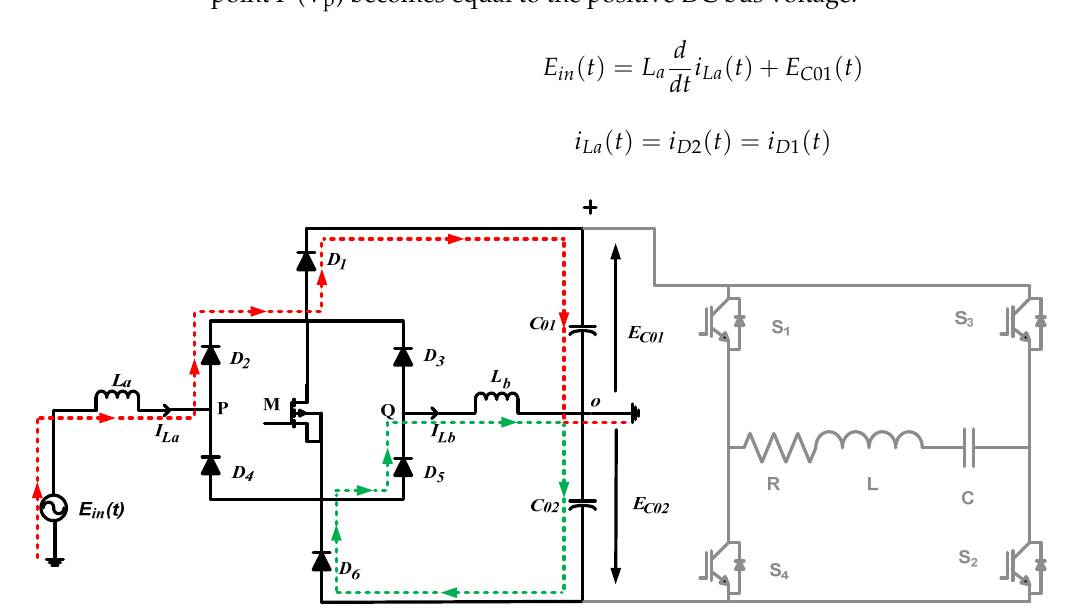
Figure 3. Proposed MVR with positive current path and open switch.